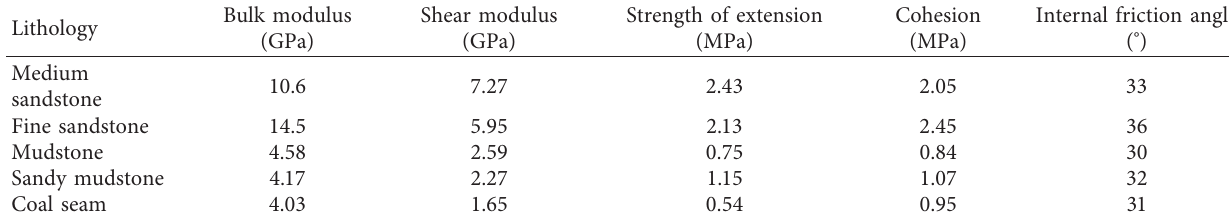
Table 1: The mechanical parameters of model.